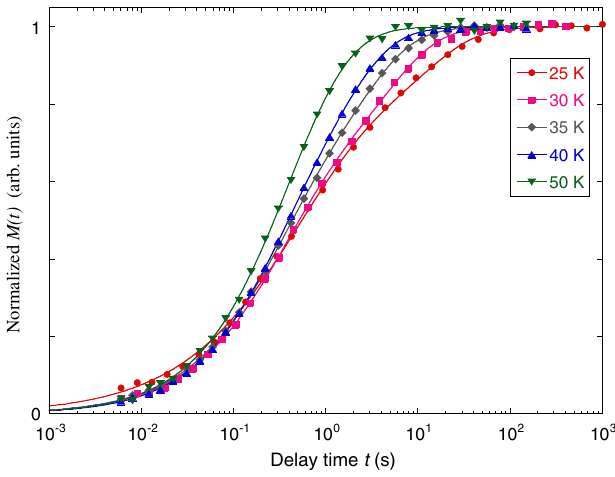
FIG. 16. Normalized T 1 recovery curves M ð t Þ measured in B 9 T at selected temperatures for the I ext ¼ lower satellite transition of 63 Cu ð I Þ sites. Solid curves represent the two-component fit with Eq.